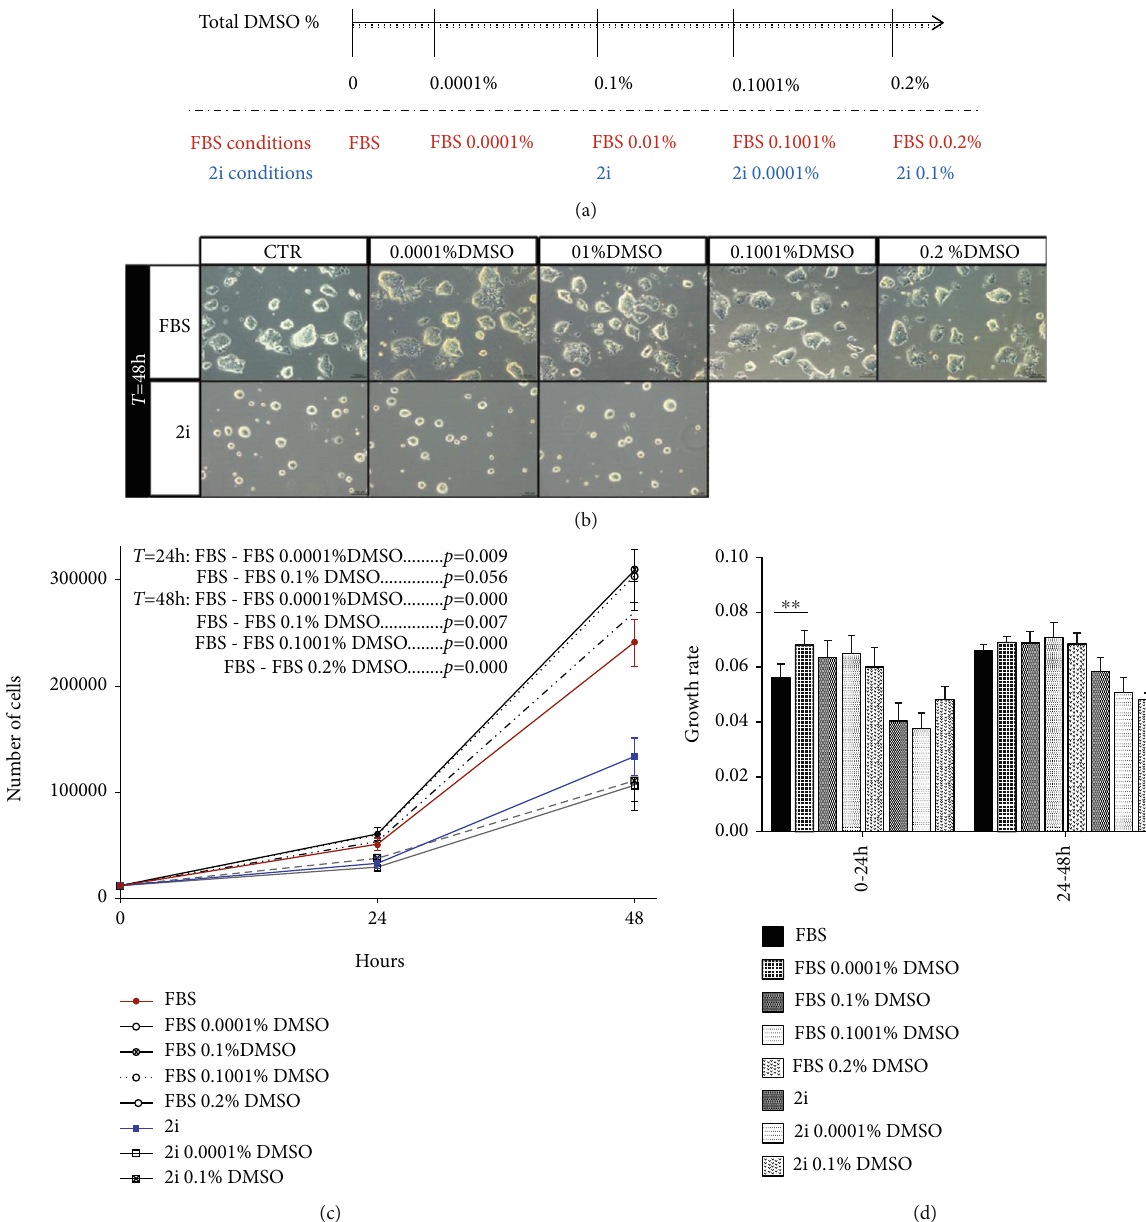
Figure 1: A small amount of DMSO has minimal e ff ects in mESC culture. mESCs were cultured in two di ff erent media that mimic the naive pluripotency state and were kept in culture for 48 hours in the presence or absence of DMSO (control conditions — 2i, FBS; DMSO-incubated conditions — 0.0001% DMSO, 0.1% DMSO, 0.1001% DMSO, and 0.2% DMSO). (a) Schematic representation of the DMSO conditions